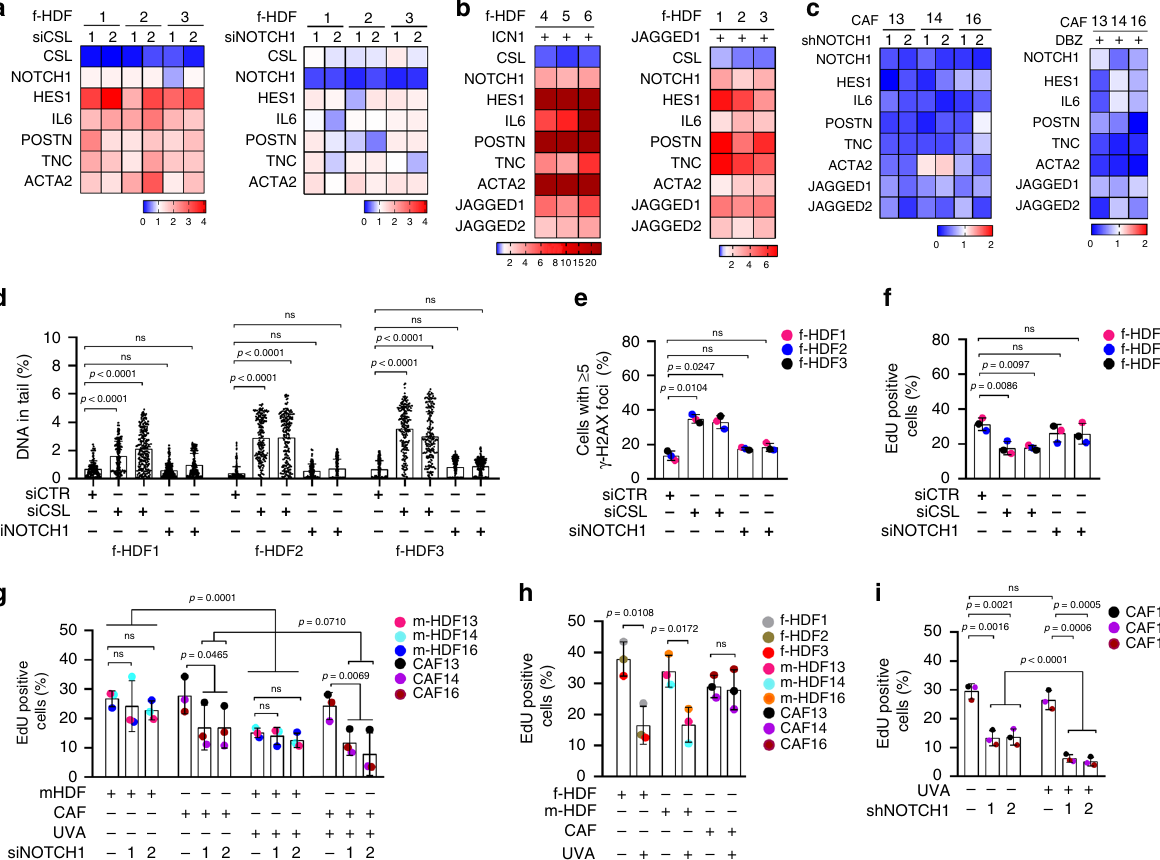
Fig. 3 Consequences of modulation of NOTCH1 expression and activity in HDFs and CAFs. a – c Heatmap of changes in gene expression of the indicated genes in: a f-HDF strains plus/minus CSL or NOTCH1 silencing by two different siRNAs versus siRNA controls for 3 days; b f-HDF strains infected with a lentivirus for doxycycline-inducible expression of ICN1 versus empty vector control, 5 days after ICN1 induction or cultured on JAGGED 1-coated versus IgG coated control dishes for 3 days; c CAF strains infected with two different NOTCH1 silencing lentiviruses versus empty vector control for 5 days or treated with the γ -Secretase Inhibitor DBZ (10 μ M) versus DMSO vehicle alone for 5 days. Results are shown as gene expression folds (down- or up-regulation in blue and red, respectively). Individual bar plots and statistical quanti fi cation of the results are shown in Supplementary Fig. 2a – c. d Comet assays of f-HDF strains with or without CSL and NOTCH1 silencing. The percentage DNA in tail for individual cells is indicated by scatter dot plot. >184 cells were analyzed per sample. One-way ANOVA followed by Dunnett ’ s test. n (f-HDF strain) = 3. e Immuno fl uorescence analysis with antibodies against γ -H2AX of f-HDF strains plus/minus CSL and NOTCH1 silencing. >201 cells were analyzed per sample. One-way ANOVA followed by Dunnett ’ s test. n (f-HDF strain) = 3. n (CAF strain) = 3. f – i EdU assays of: f f-HDF strains plus/minus CSL and NOTCH1 silencing. n (cells) >201, One-way ANOVA followed by Dunnett ’ s test n (f-HDF strain) = 3; g m-HDF and CAF strains plus/minus siRNA mediated NOTCH1 gene silencing and plus/minus UVA irradiation. 24 h after siRNA transfection cells were mock treated or irradiated with UVA (500 mJ/cm 2 ), followed by EdU labeling 48 h later, n (cells)> 99, two-way ANOVA between groups and two-tailed unpaired t -test within each group, n (m-HDF strain) = 3, n (CAF strain) = 3; h f-HDF, m-HDF, and CAF strains 72 h after UVA irradiation (500 mJ/cm 2 ) versus mock treated, n (cells)>89, two-tailed unpaired t -test, n (CAF strain) = 3. n (f-HDF strain) = 3, n (m-HDF strain) = 3, and n (CAF strain) = 3; i CAF strains plus/minus shRNA-mediated NOTCH1 silencing for 7 days and plus/minus UVA irradiation as in h . n (cells) >103, two- tailed unpaired t -test, n (CAF strain) = 3. All data represented as Mean ± s.d, * p < 0.05, ** p < 0.01, *** p < 0.001, **** p <